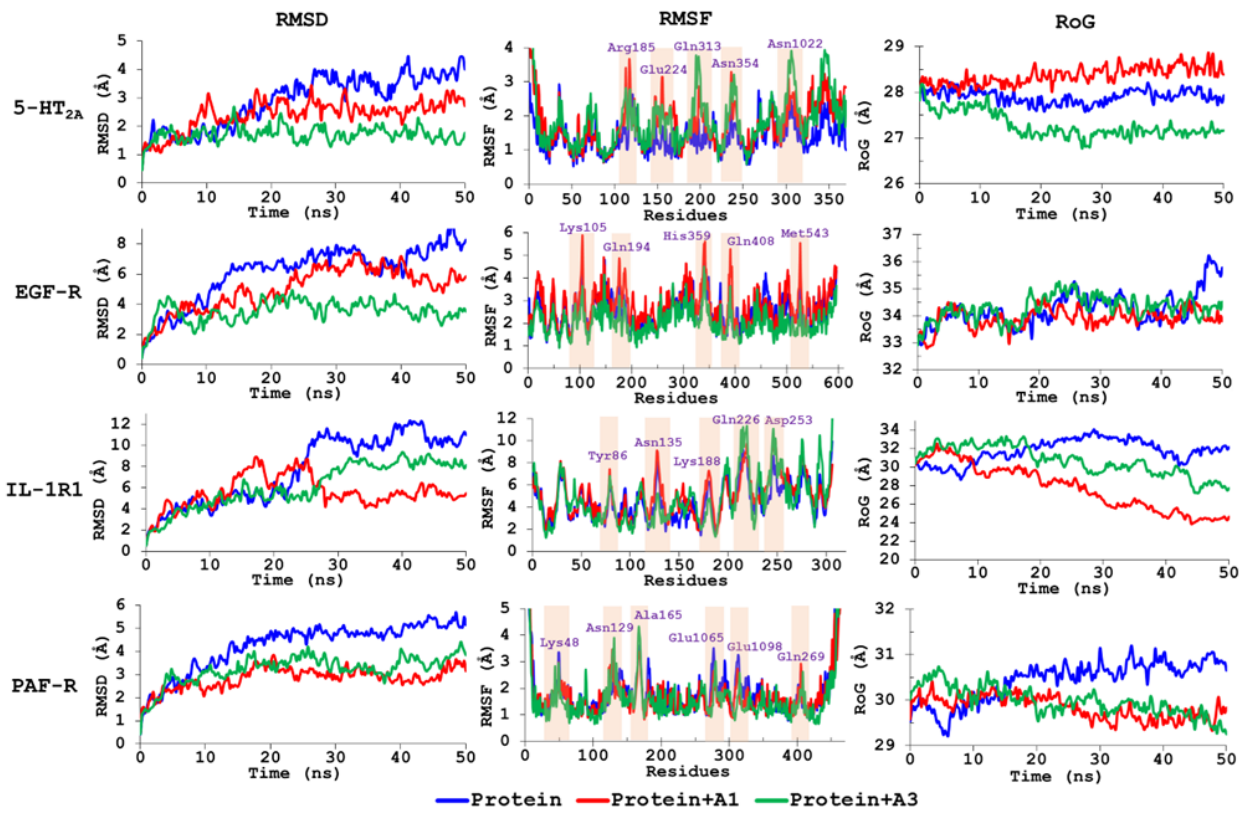
Figure 11. Molecular dynamics (MD) simulations during 50 ns for target proteins alone, i.e., 5 ‐ HT2A, EGF ‐ R, IL ‐ 1R1, and PAF ‐ R (blue line) and docked separately with A1 (red line), and A3 (green line). First column: root mean square deviations (RMSD) along MD ‐ simulated trajectories. Second column: root mean square fluctuations (RMSF) of protein residues along MD ‐ simulated trajectories. Third column: radius of gyration (RoG) along MD ‐ simulated trajectories.